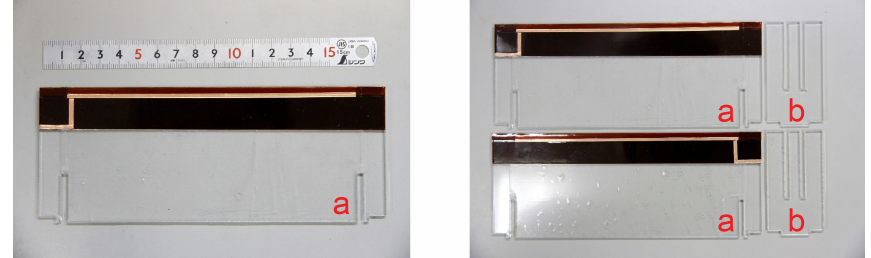
Figure 8. Parts (a) and (b) to construct the nozzle